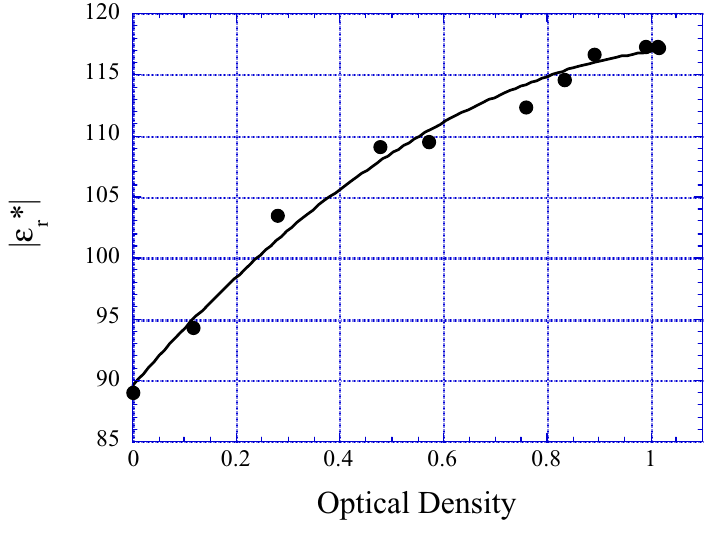
Figure 5. Correlation between LC sensor and optical density measurements of a bacteria laden